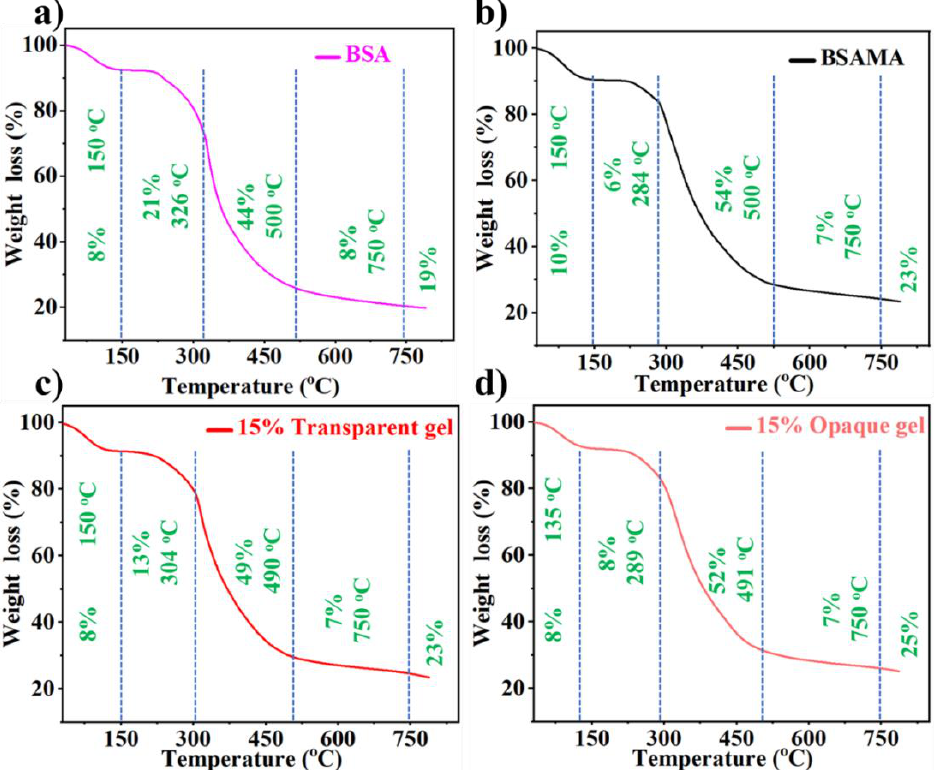
Figure 6. Thermal stability by TGA. ( a ) BSA, ( b ) BSAMA, BSAMA (15% ( w / v ))-based ( c ) transparent and ( d ) opaque gels.